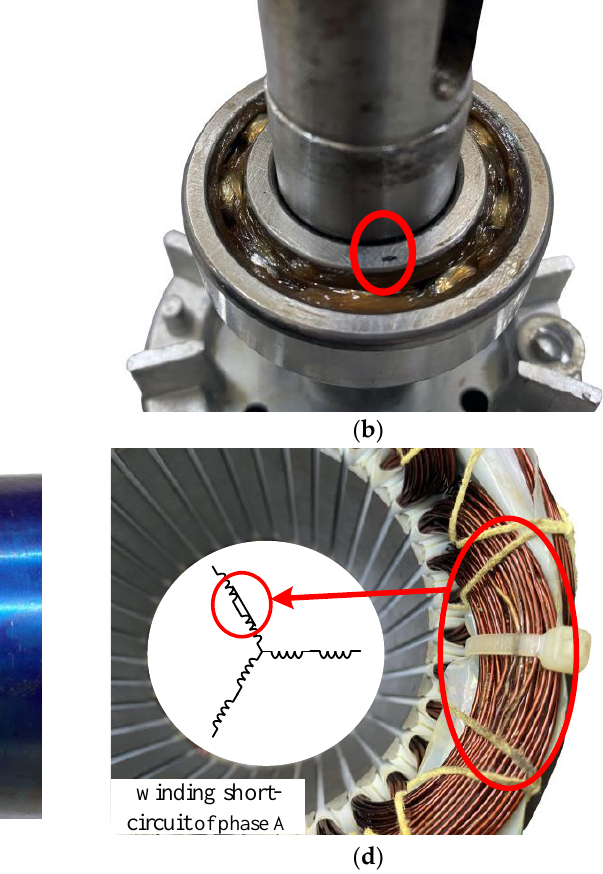
(cid:72) 8 mm deep 10 mm),